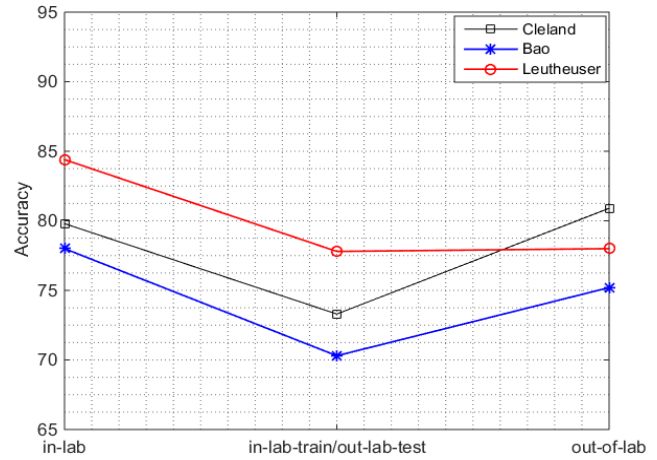
Figure 5. Performance analysis of in-lab, out-of-lab, and in-lab training/out-lab testing scenario for all PAC systems using a reductionist approach.